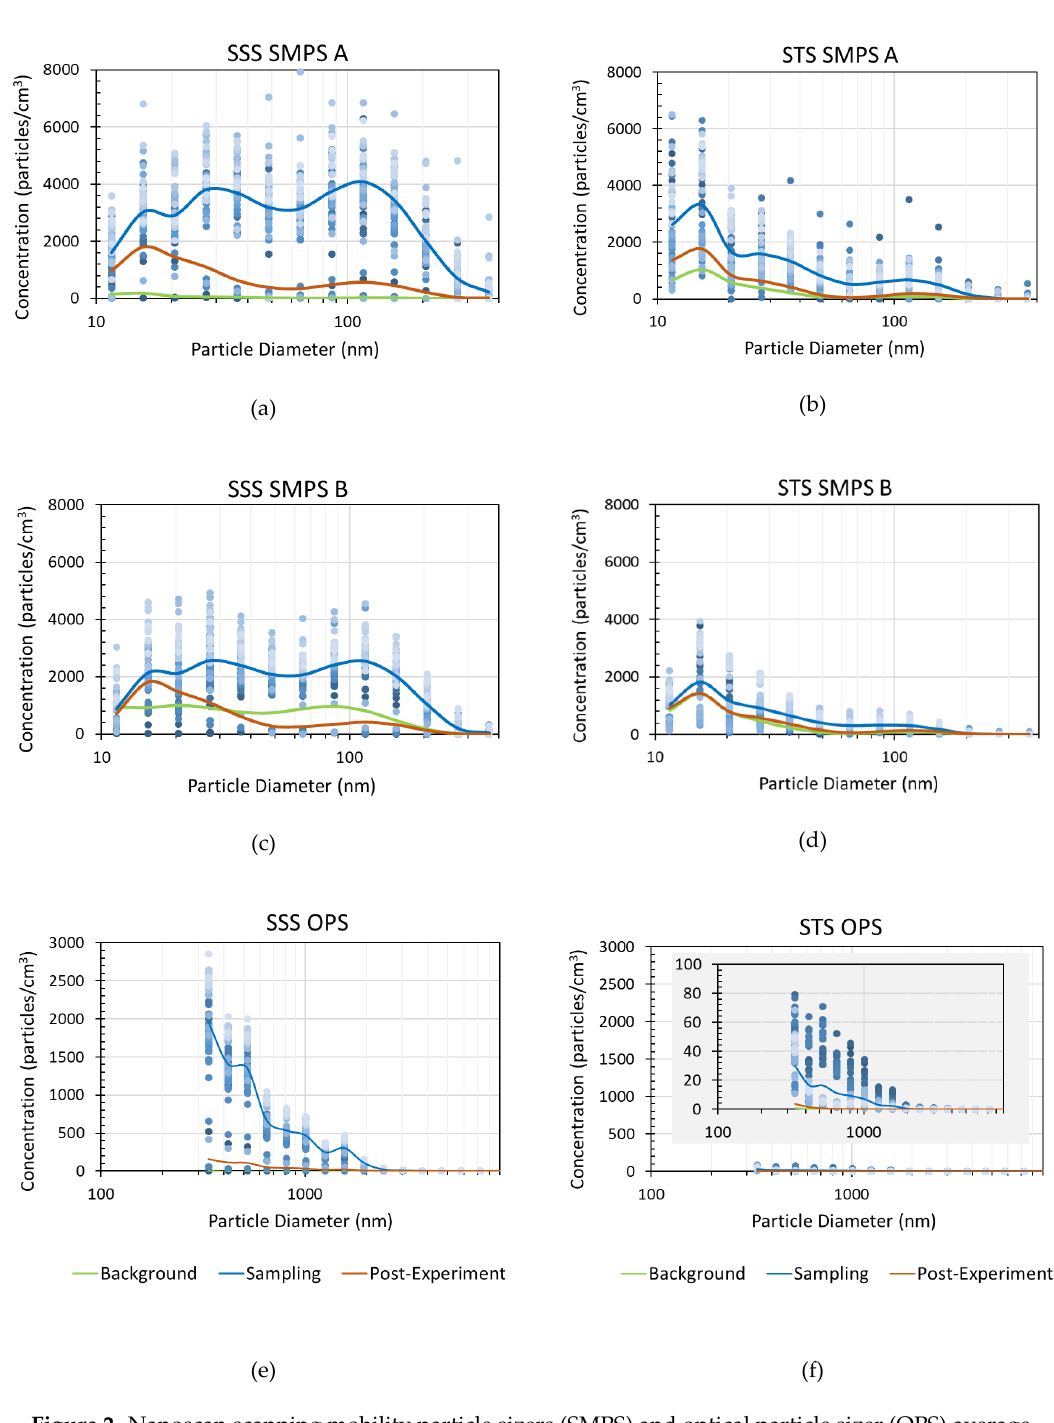
Figure 2. Nanoscan scanning mobility particle sizers (SMPS) and optical particle sizer (OPS) average data across 3 trials of aerosolized particle size distribution for three time periods, i.e., Background, Sampling, and Post Sampling periods. ( a ) – ( c ) Adjusted size distribution of the particles released from SSS. ( d ) – ( f ) Adjusted size distribution of the particles released from STS across 3 trials. Note: Standard deviation data are presented in the supplementary information (SI) file.